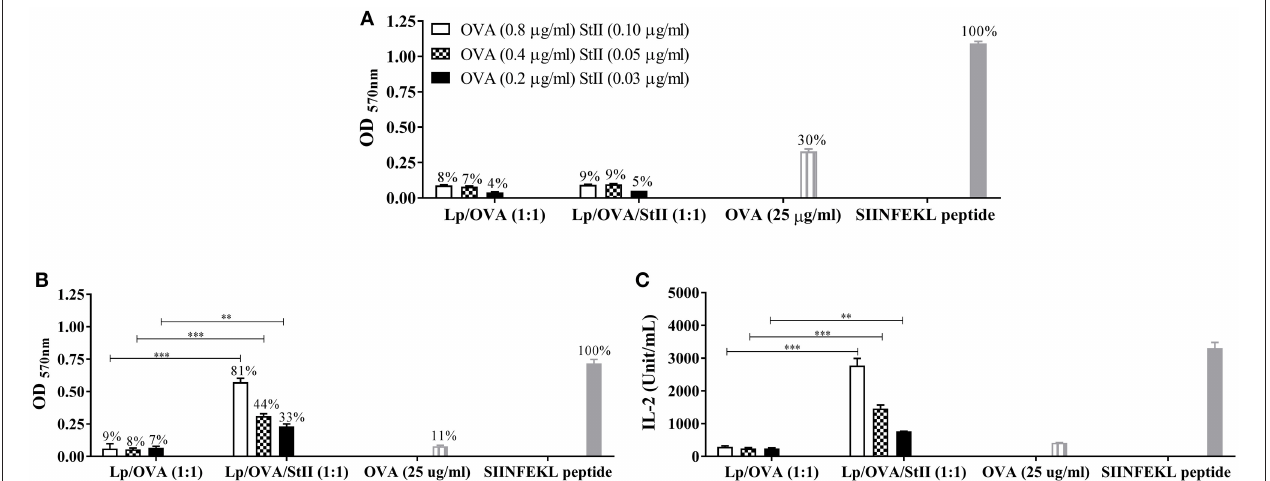
FIGURE 1 | StII co-encapsulated with OVA into liposomes induces the antigen cross-presentation in bone marrow-derived macrophages (BM-M 8 s) but not in bone marrow-derived dendritic cells (BM-DCs). (A) Bone marrow-derived DCs (BM-DCs) and (B,C) Bone marrow-derived macrophages (BM-M 8 s) from C57BL/6 mice were incubated with the indicated concentrations of OVA co-encapsulated with or without StII into DPPC:Chol liposomes (1:1) [Lp/OVA/StII (1:1) and Lp/OVA (1:1), respectively]. Both APC incubated with either 25 µ g/ml of soluble OVA and 10nM of SIINFEKL peptide were used as controls. After stimulation, cells were washed and co-cultured with OVA-specific B3Z CD8 + T cells. β -galactosidase activity of the B3Z cells was measured by a colorimetric assay. (A,B) Mean ± SEM of optical density at 570nm (OD 570nm ) of four independent experiments performed with BM-DCs and BM-M 8 s, respectively, are shown. Efficiency of antigen cross-presentation with respect to the SIINFEKL peptide is also shown above each bar. (C) IL-2 concentration in culture supernatants from BM-M 8 s was measured by ELISA. Statistical analysis was performed with the Mann–Whitney U -test: ** p < 0.01, *** p <